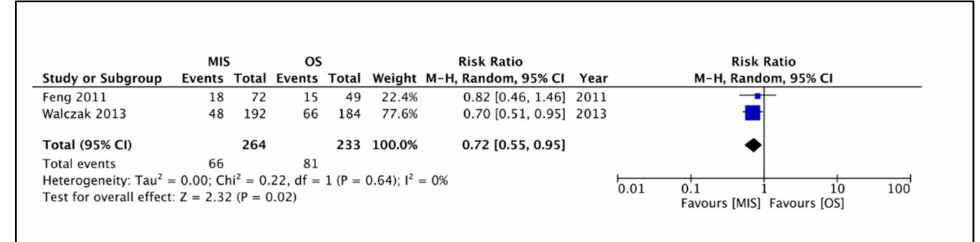
Figure 3. Forest plot comparison between the two patient groups in terms of the incidence of microscopic glove perforations. Legends: MIS, minimally invasive surgery group. OS, open surgery group. M-H, Mantel–Haenszel method. CI, confidence